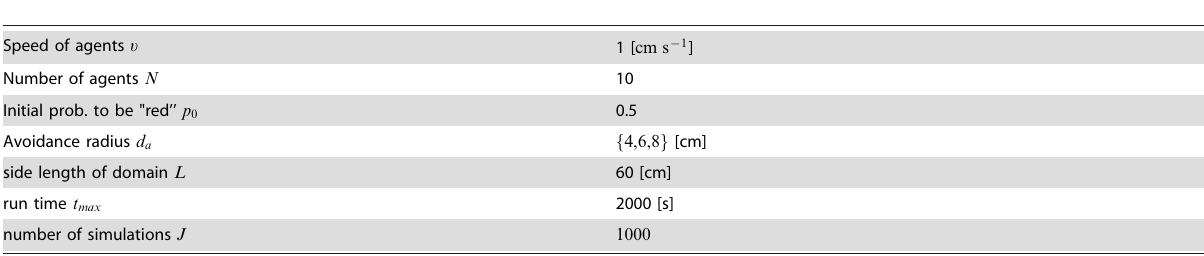
Table 2. Parameters for the kilobot swarm and the microscopic simulation of it using Flame.